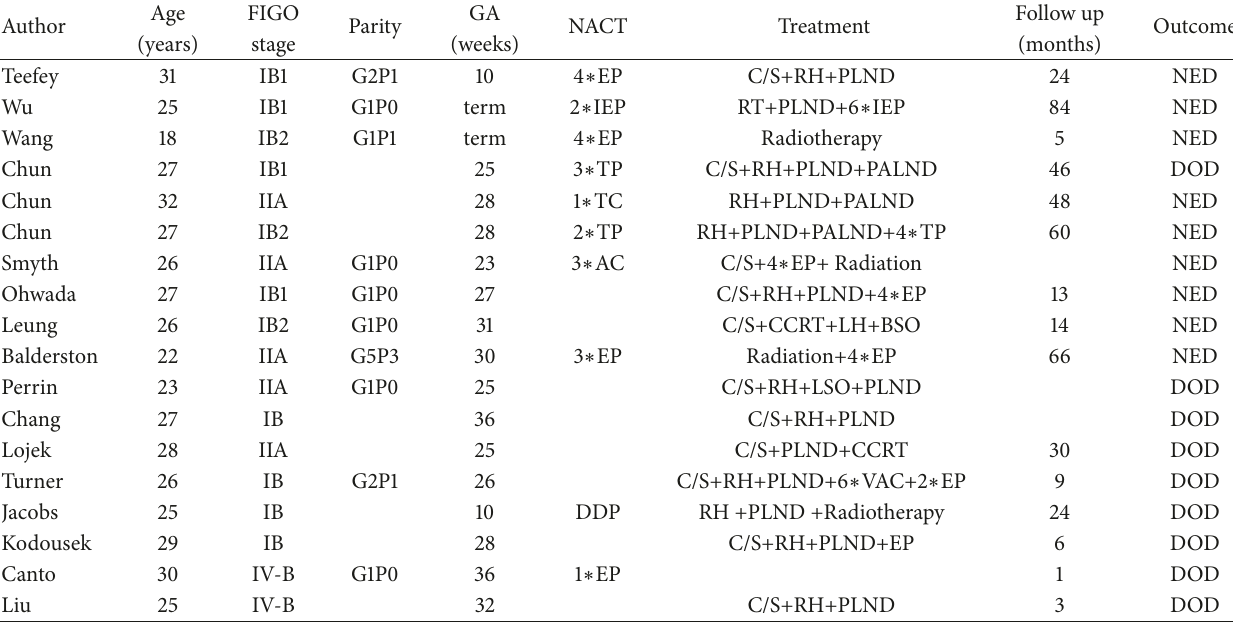
FIGO,InternationalFederationofGynecologyandObstetrics;GA,gestationalage;NACT,neoadjuvantchemotherapy;EP,cisplatin+etoposide;TP,Paclitaxel+ Cisplatin; TC, Paclitaxel+carboplatin; VAC,vincristine+doxorubicin+ cyclophosphamide; IEP, ifosfamide+ cisplatin+ etoposide; C/S, cesarean section; RH,